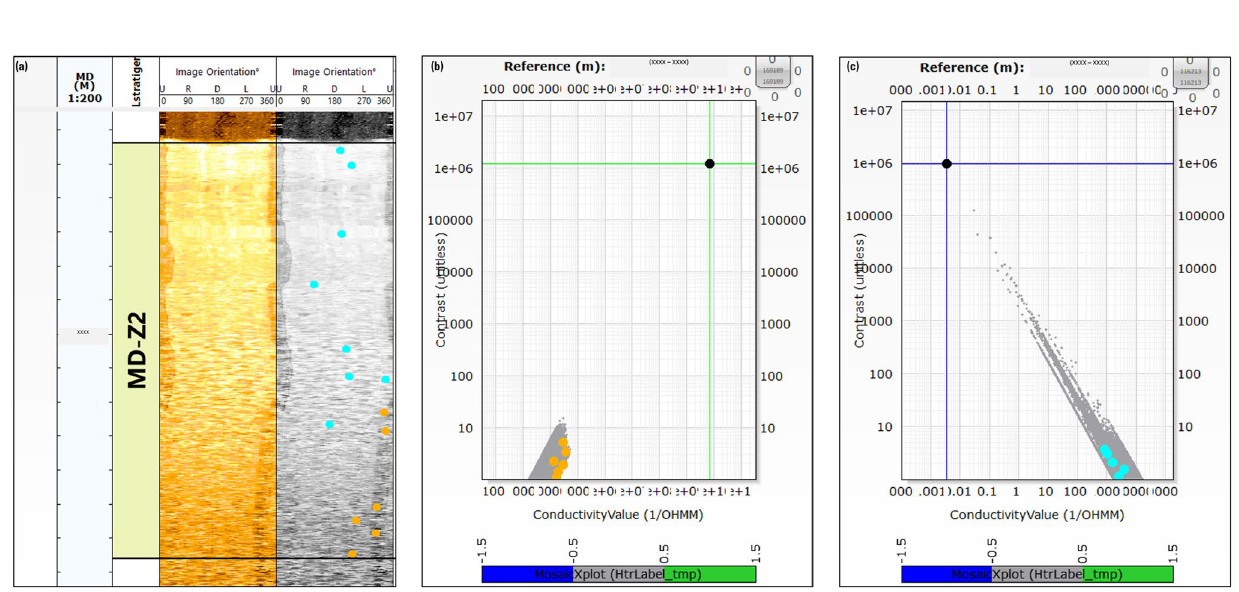
Fig. 14 a Mosaic index image, b Conductivity and c Resistivity of the matrix for well #4 before indexing resistive and conductive